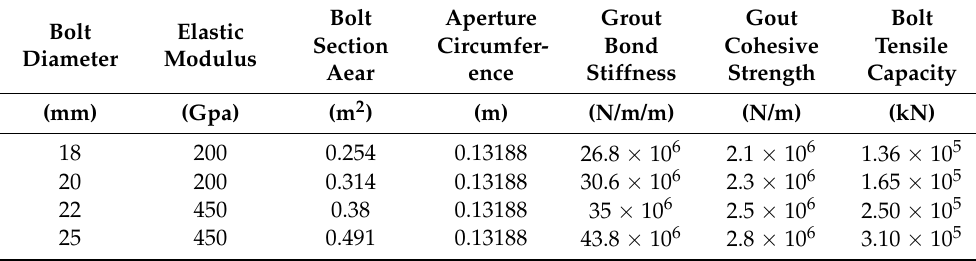
Table 4. The mechanical parameters of the bolt in numerical modeling.